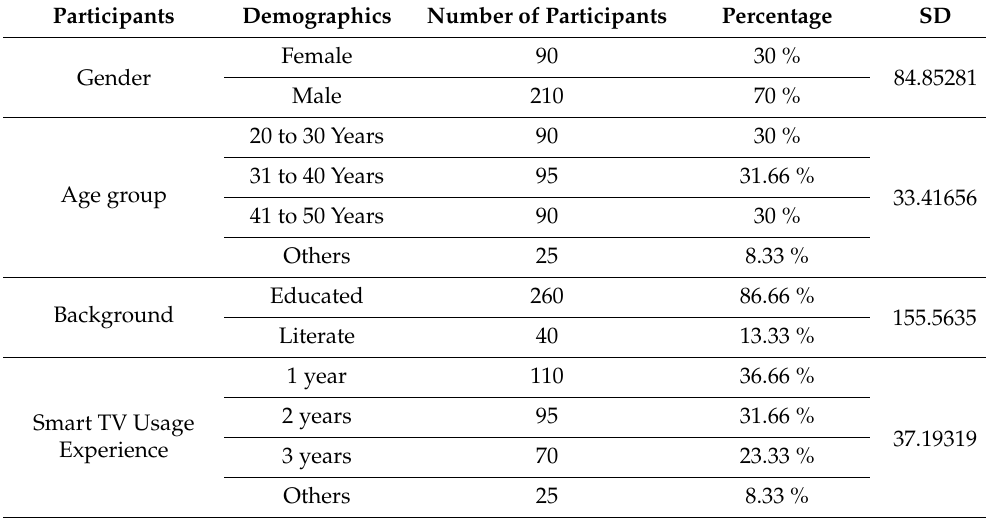
Table 3. Demographic